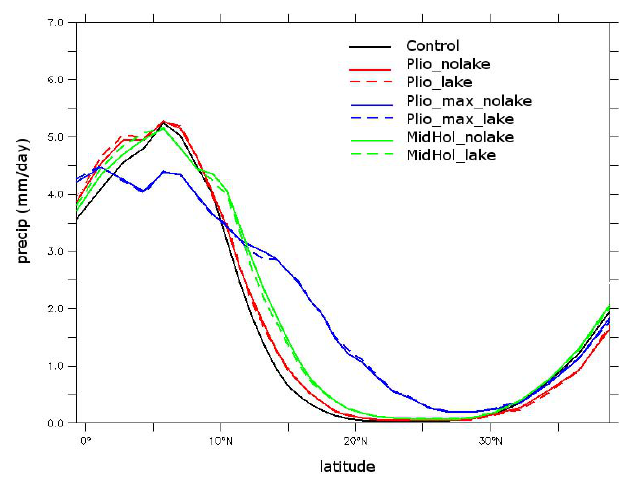
Fig. 4. Mean annual precipitation simulated with LMDZ4 in func- tion of latitude, averaged over 20 ◦ W to 40 ◦